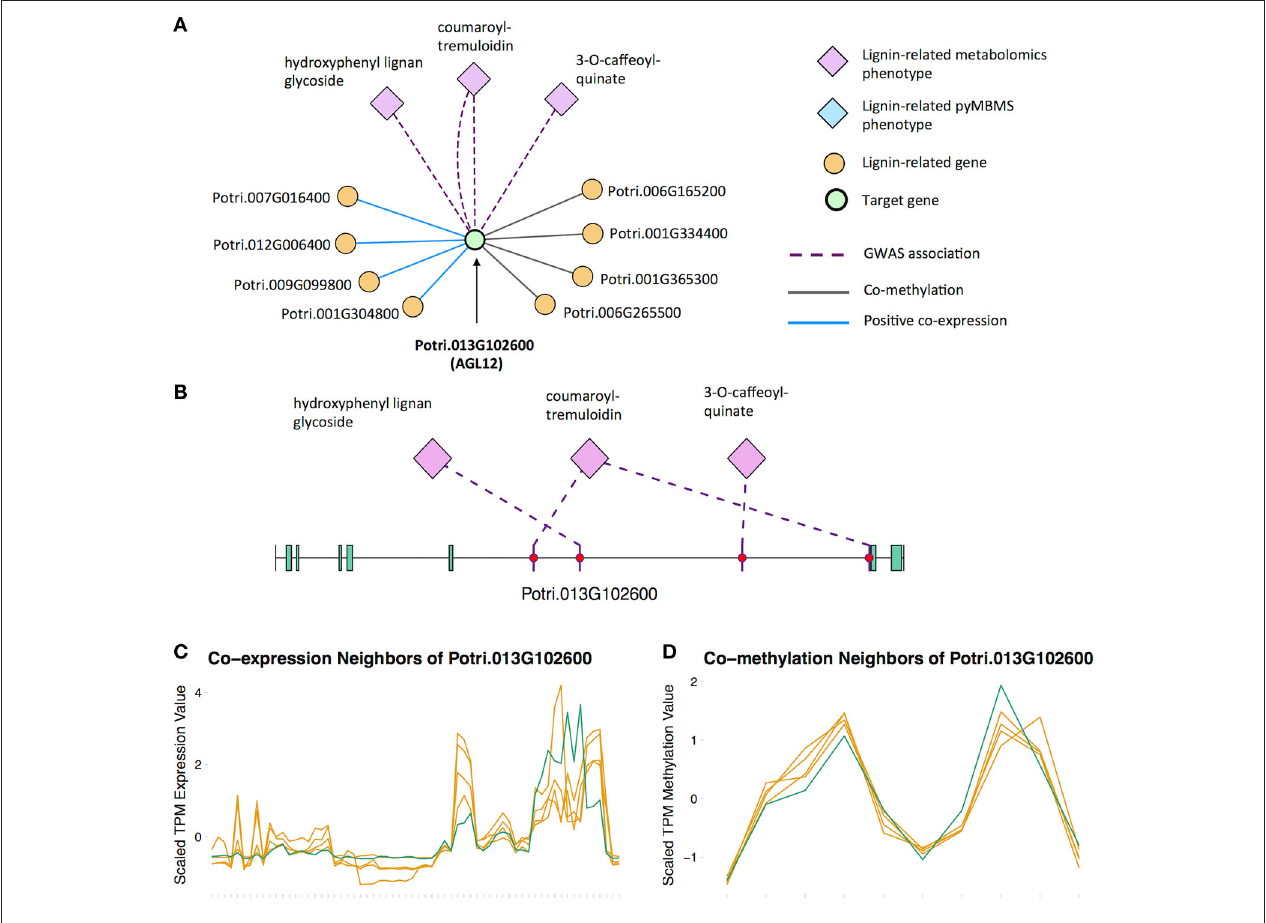
FIGURE 4 | (A) Lines of evidence for Potri.013G102600 (homolog of Arabidopsis AGL12). (B) GWAS associations of Potri.013G102600 with three lignin-related metabolites ( Table 1 ). (C) Co-expression of Potri.013G102600 with three lignin-related genes ( Table 2 ). (D) Co-methylation of Potri.013G102600 with four lignin-related genes ( Table 3 ). In line plots, the green lines represent potential target Potri.013G102600 and yellow lines represent lignin-related genes.